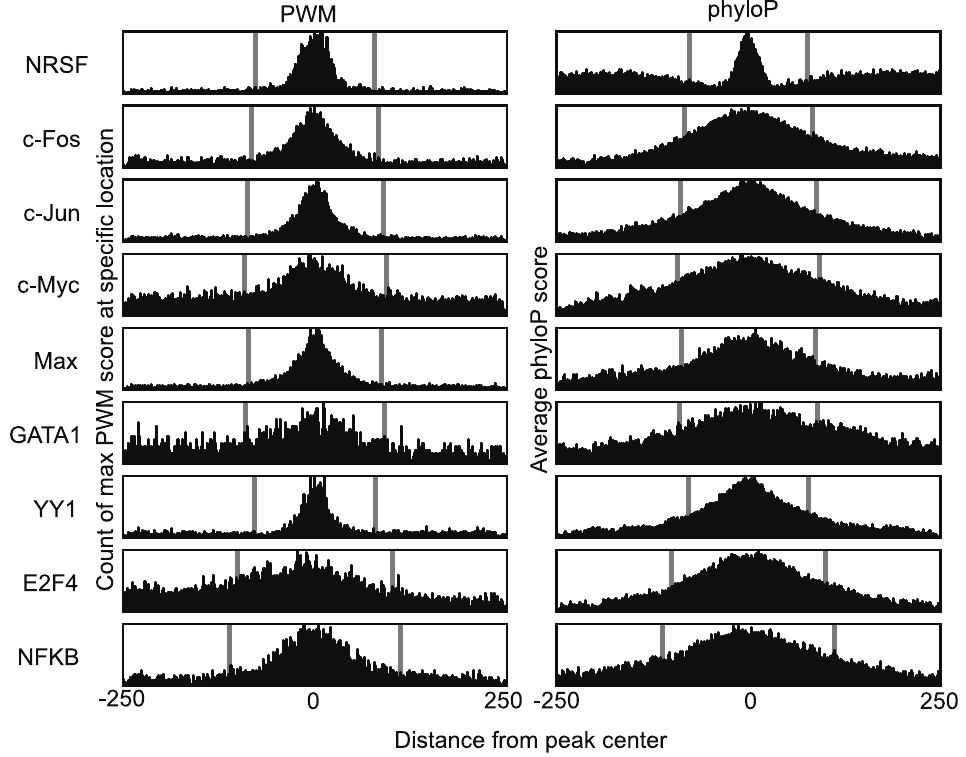
Figure 4. Max PWM score and phyloP values correlate with center of peak regions. The figures show a region of 500 bp surrounding each peak region. On the left is shown for each of the 500 positions the number of times that position has the maximum PWM score in the 500 bp region. On the right is the average phyloP score. The grey lines show the average peak width. Both max PWM score and higher phyloP values tend to be clustered in the center of the peak regions, but the clustering varies for each TF.